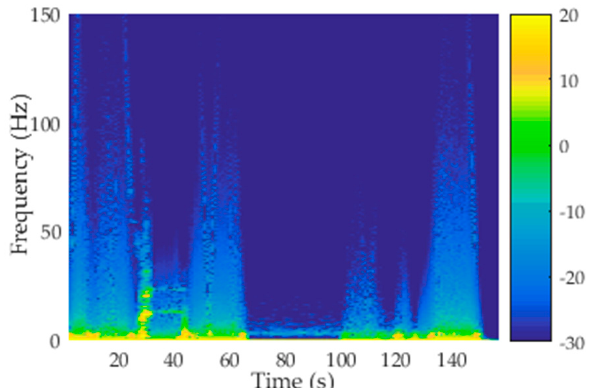
Figure 22. STFT of TM speed with control.